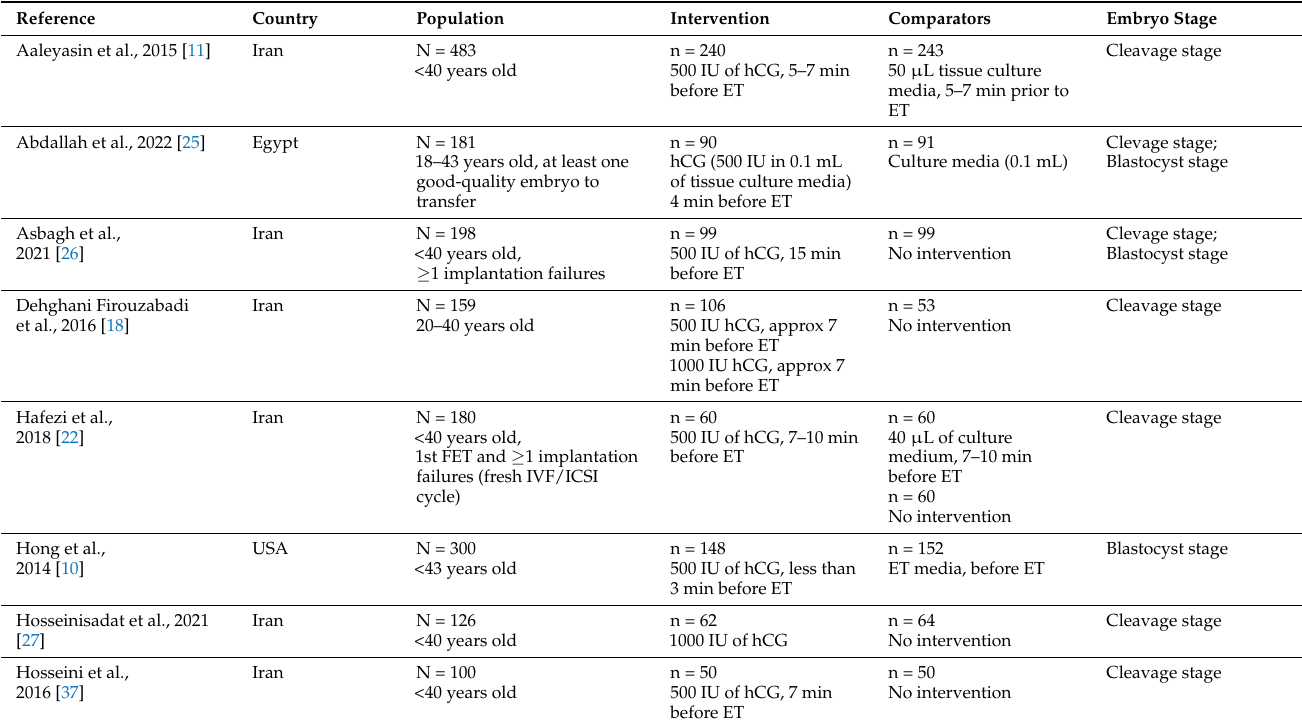
Figure 1. Study flow chart according to PRISMA guidelines. Table 1. Characteristics of studies included.